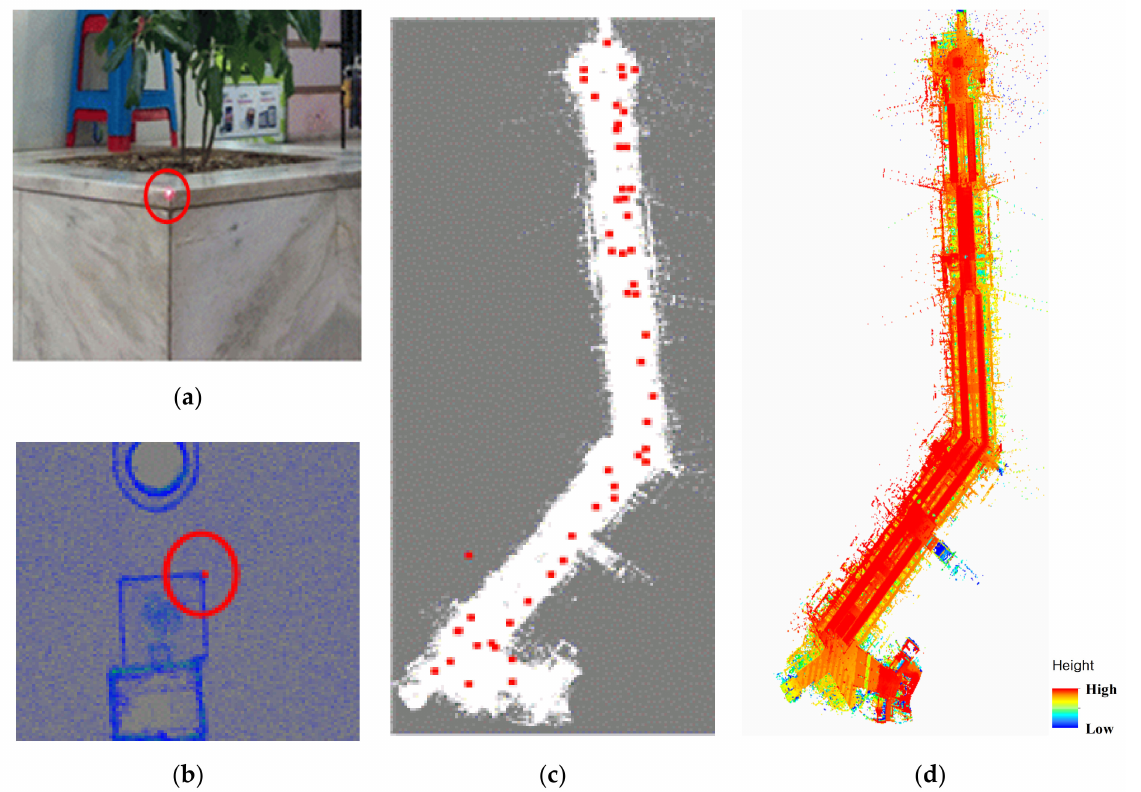
Figure 3. Absolute coordinate conversion and point cloud data integration. ( a ) Observed control point. ( b ) Matching the control point and point cloud data. ( c ) Control point and point cloud data. ( d ) Matched point cloud data. Color is a relative height value, higher is red and lower is blue.